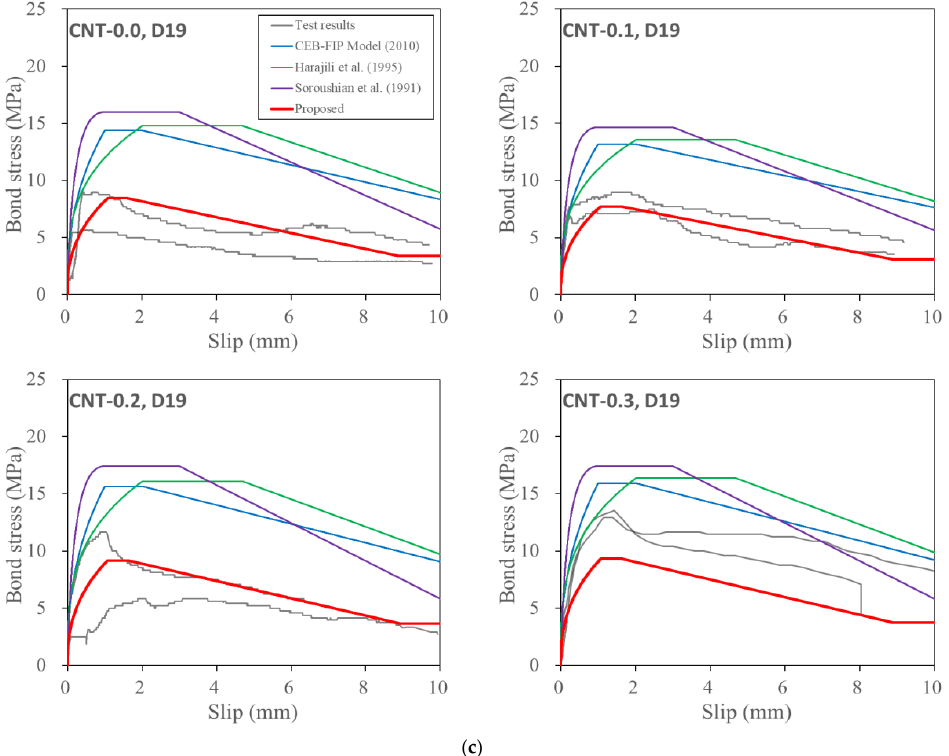
Figure 13. Comparison of the test results and bond stress-slip model: ( a ) D13 ( b ) D16 ( c ) D19, [34,36,37].